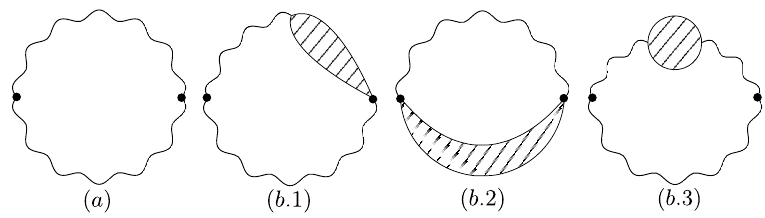
Figure 3 . Diagrams for the two-point function of the displacement operator. The leading order contribution ( a ) is the square of the two-point function of the topological current ^ I . At next-to- leading order we have the diagrams ( b: 1)-( b: 2)-( b: 3) that are also sensitive to the electric current ^ J . The shaded blobs denote insertions/correlators of ^ J in the undeformed